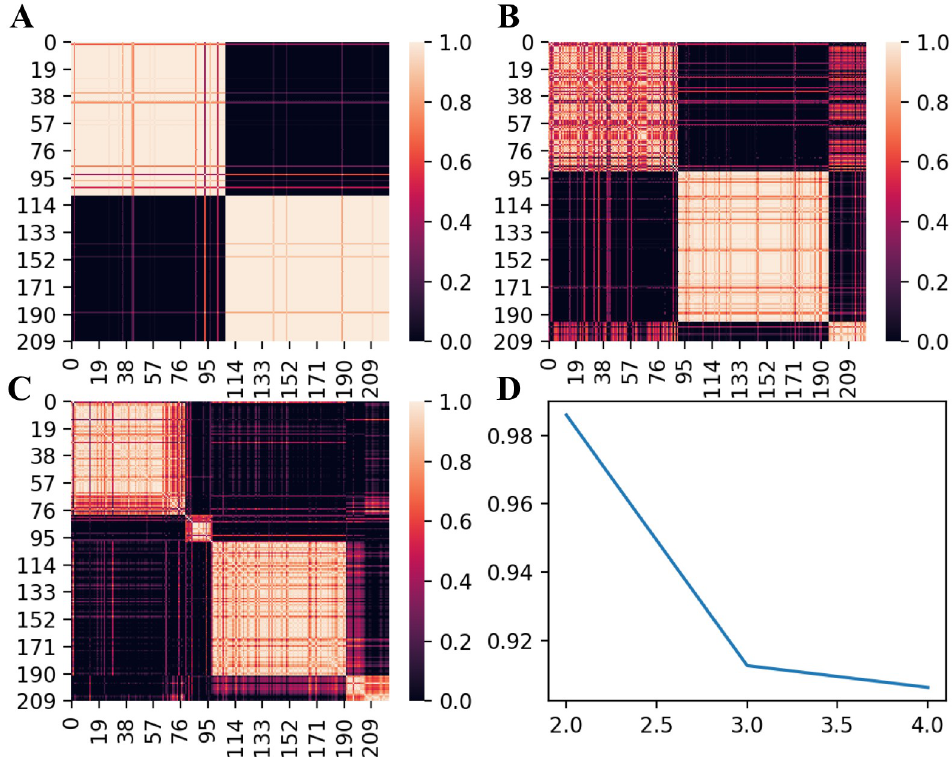
Fig 3. NMF-based clustering of gene expression data from 222 AD patients in ROSMAP. (A-C) Consensus matrices for 2, 3 and 4 clusters respectively. (D) Plot of cophenetic correlation coefficient against the number of clusters.